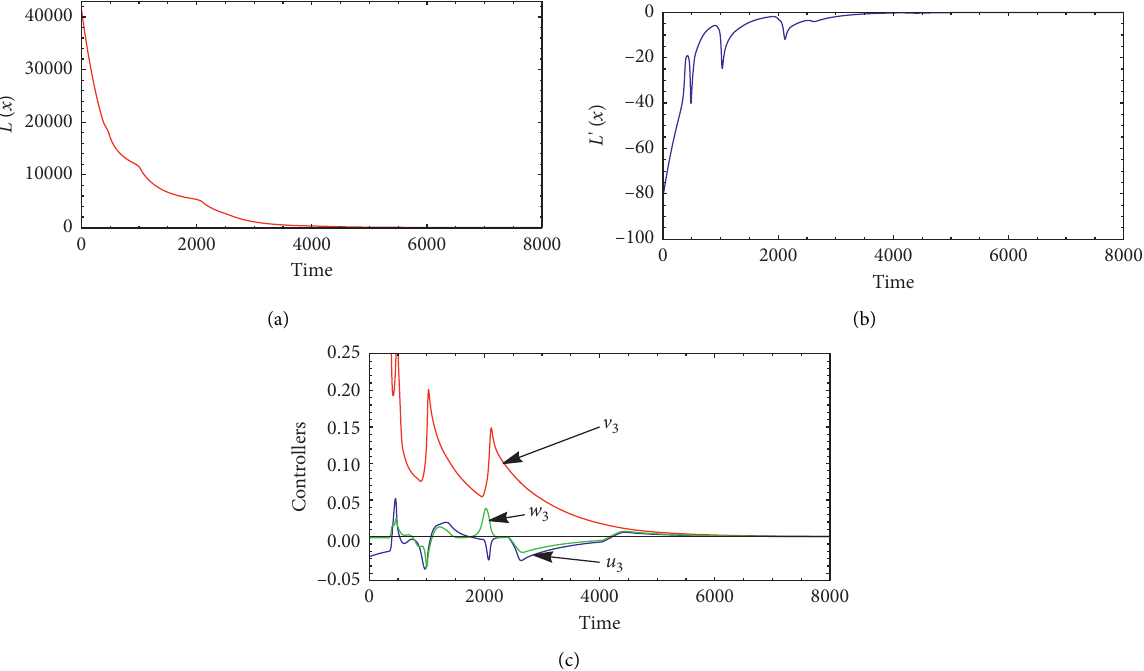
Figure 10: Scenario 3. The different viewpoints of P i while it is in motion to its target with tunnel passing maneuvers. (a) Default 3D motion view. (b) Top 3D motion view. (c) Front 3D motion